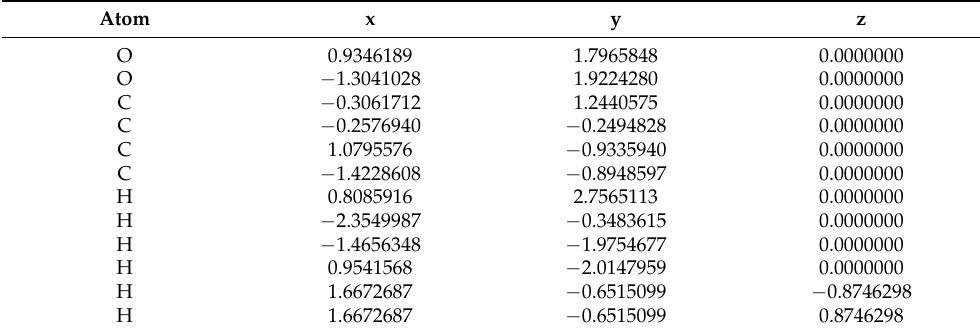
Table A1. Optimized geometry of the cis-chain (CC) conformer.